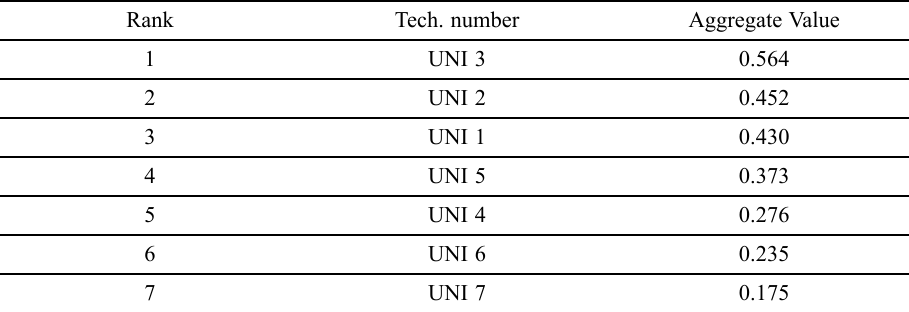
Table 12. Technology transfer office performance assessment and ranking of universities Rank Tech.